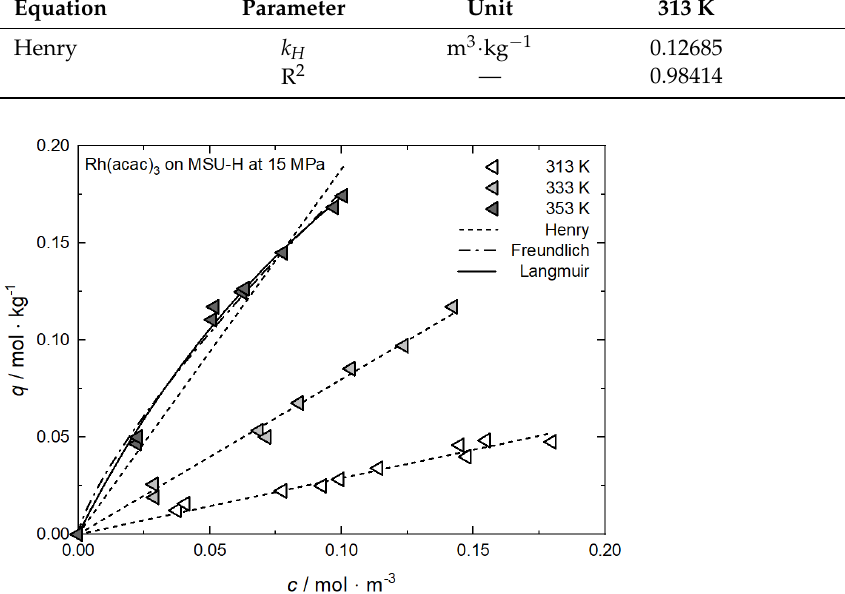
Figure A5. Uptake of Ru(acac) 3 on SA at 18 MPa and different temperatures; experimental data taken from [23]. Table A5. Adsorption isotherm parameters for Ru(acac) 3 from scCO 2 solution on SA at 18 MPa and different temperatures [23].